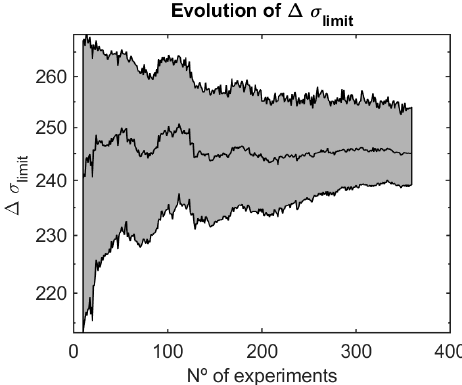
Figure 11. Evolution of the estimation of the fatigue limit and the 0.01–0.99 confidence intervals.